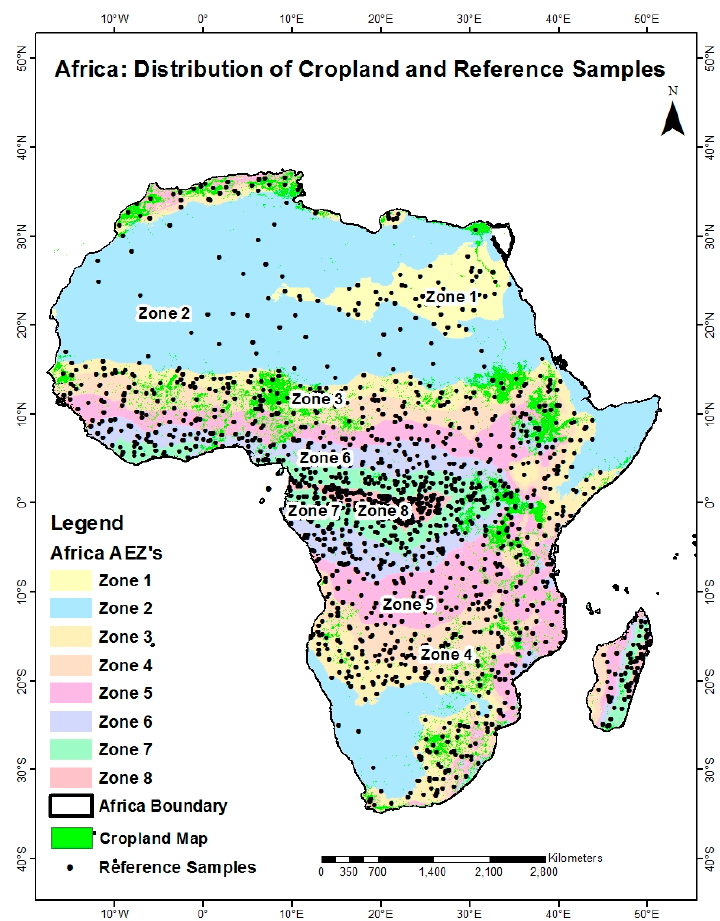
Figure 9. The distribution of Cropland and Reference Samples in Africa.